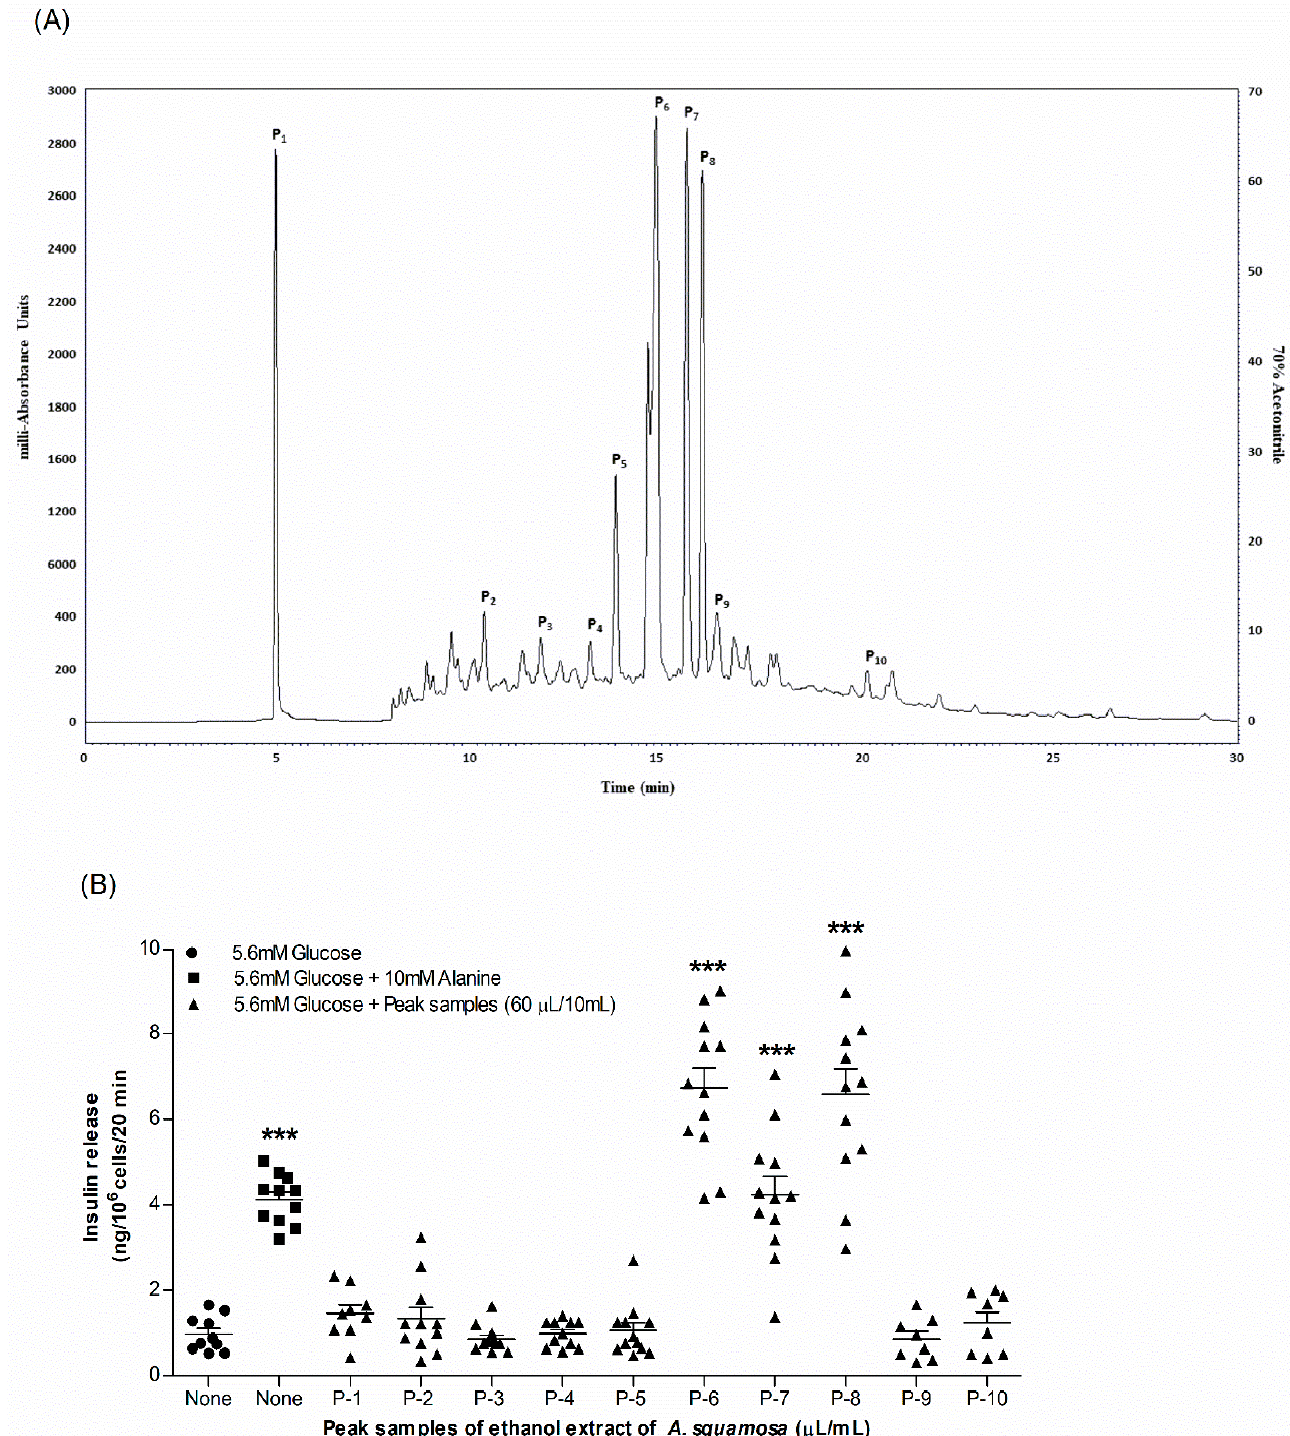
Figure 6. Representative ( A ) HPLC profile and ( B ) insulinotropic properties of EEAS peak fractions (1–10). At a flow rate of 5.0 and 1.0 mL/min, samples were run in RP-HPLC using linear gradients of 20% over 10 min and 70% over 40 min. Peak fractions (1–10) detected at 254 nm were further tested for insulin-releasing properties using clonal pancreatic BRIN-BD11 β -cells. Values n = 8 for insulin release are mean ± SEM. *** p < 0.001 compared to control.